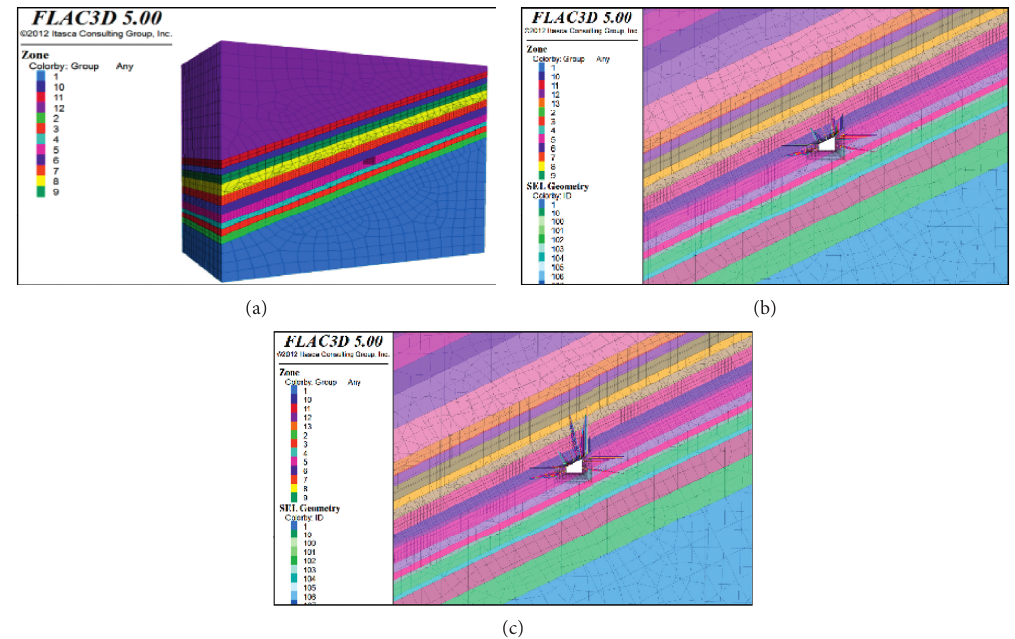
Figure 5: Support model. (a) Unsupported. (b) Bolt support. (c) Bolt-anchor cable support.